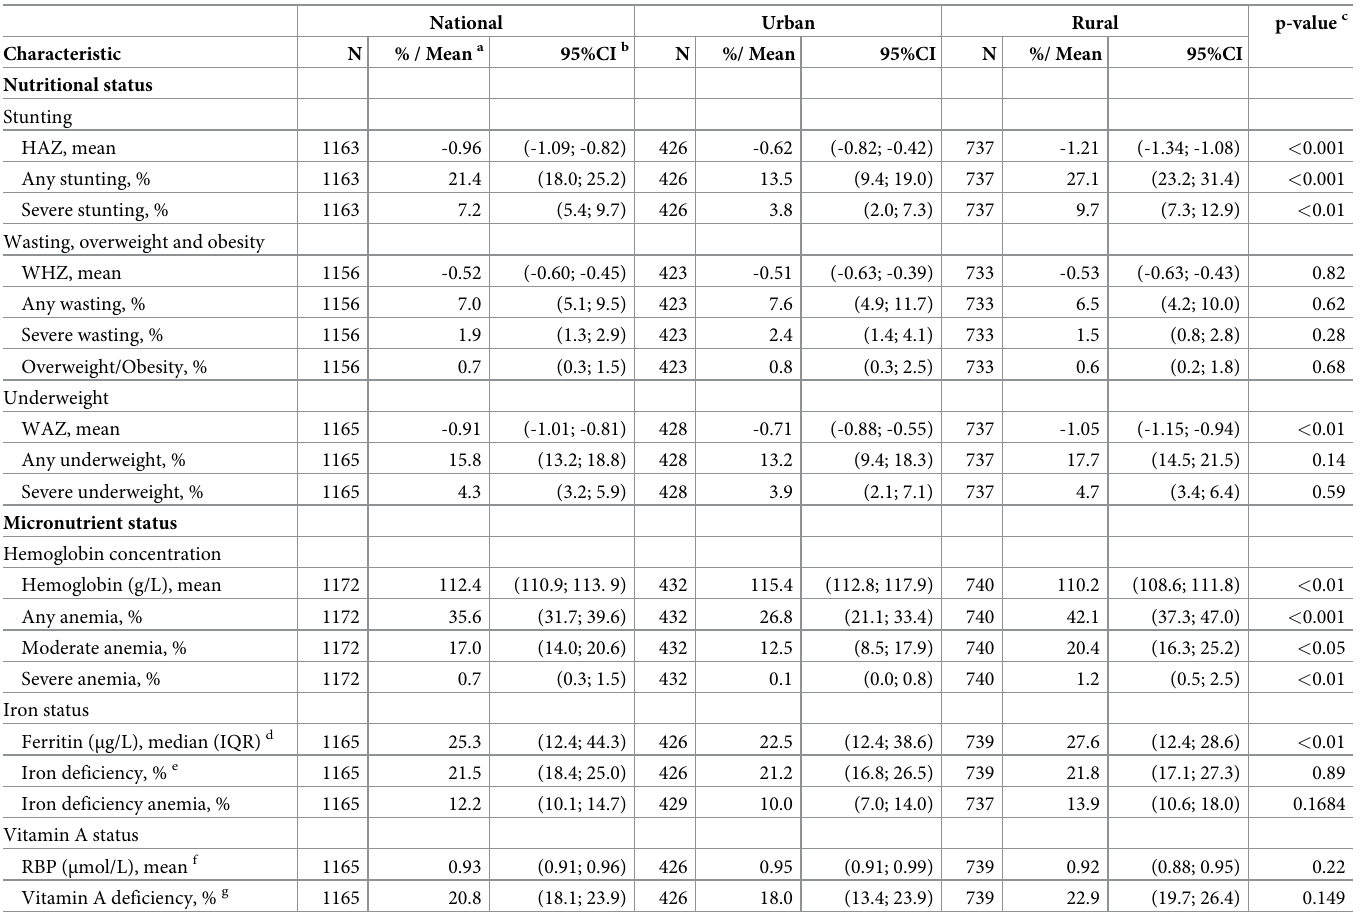
Table 2. Nutritional and micronutrient status among preschool-age children, Ghana 2017.